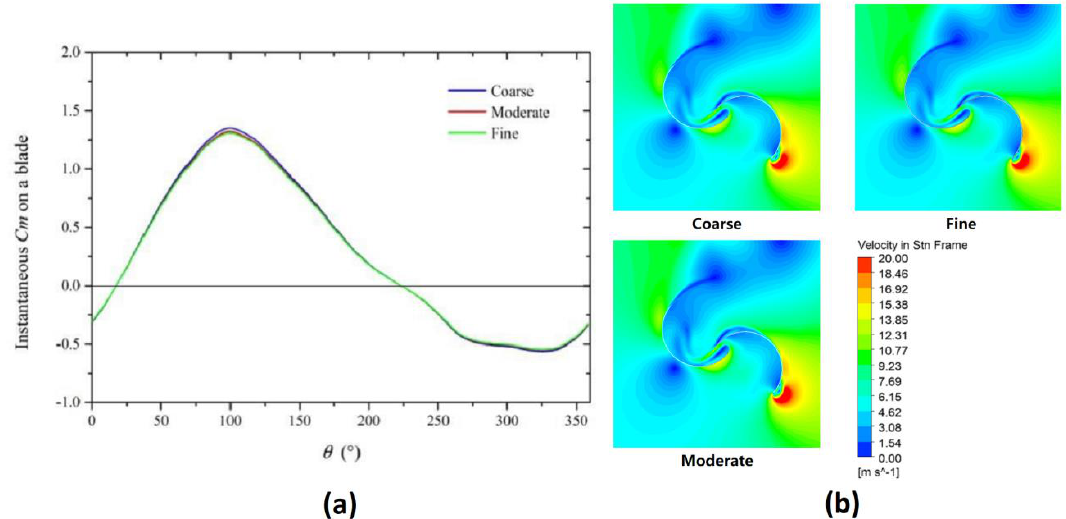
Figure 7. Mesh density verification. ( a ) Cm of a blade under different grid numbers; ( b ) velocity distribution under different grid numbers.